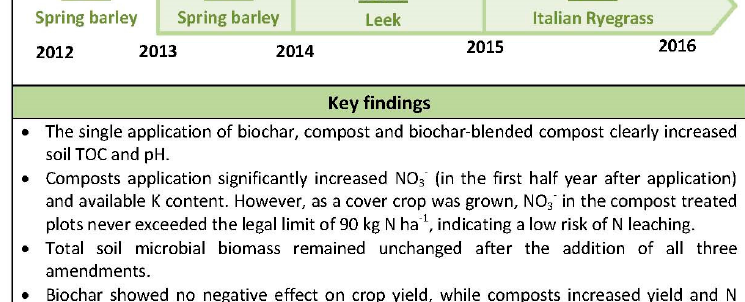
Figure 3. Description of the field scale experiment in Belgium: arable crop rotation with vegetables.